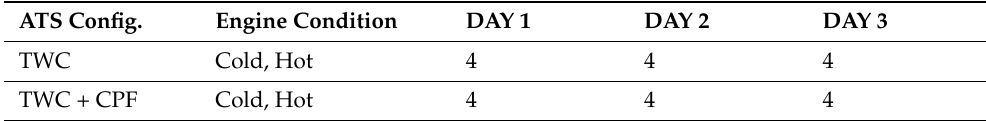
Table 9. CPF WHTC test matrix.